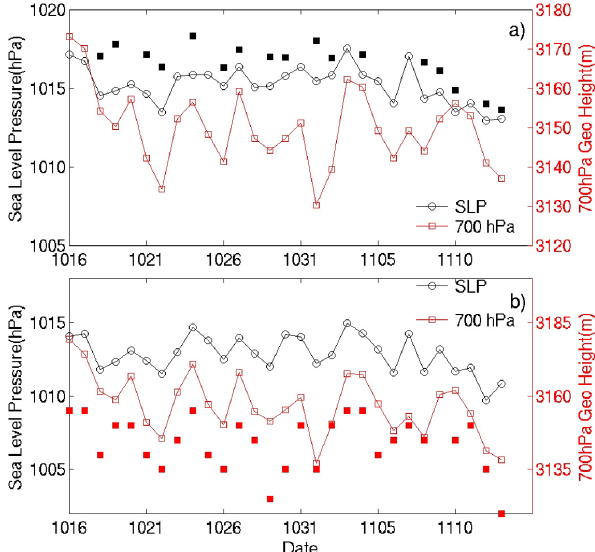
Fig. 5. Synthesis of sea level pressure and 700hPa geopotential height (a) at Point Alpha, and (b) at Iquique from NCEP reanaly- sis (12:00UTC, open symbols) and radiosonde data ( ∼ 12:00UTC, solid symbols).